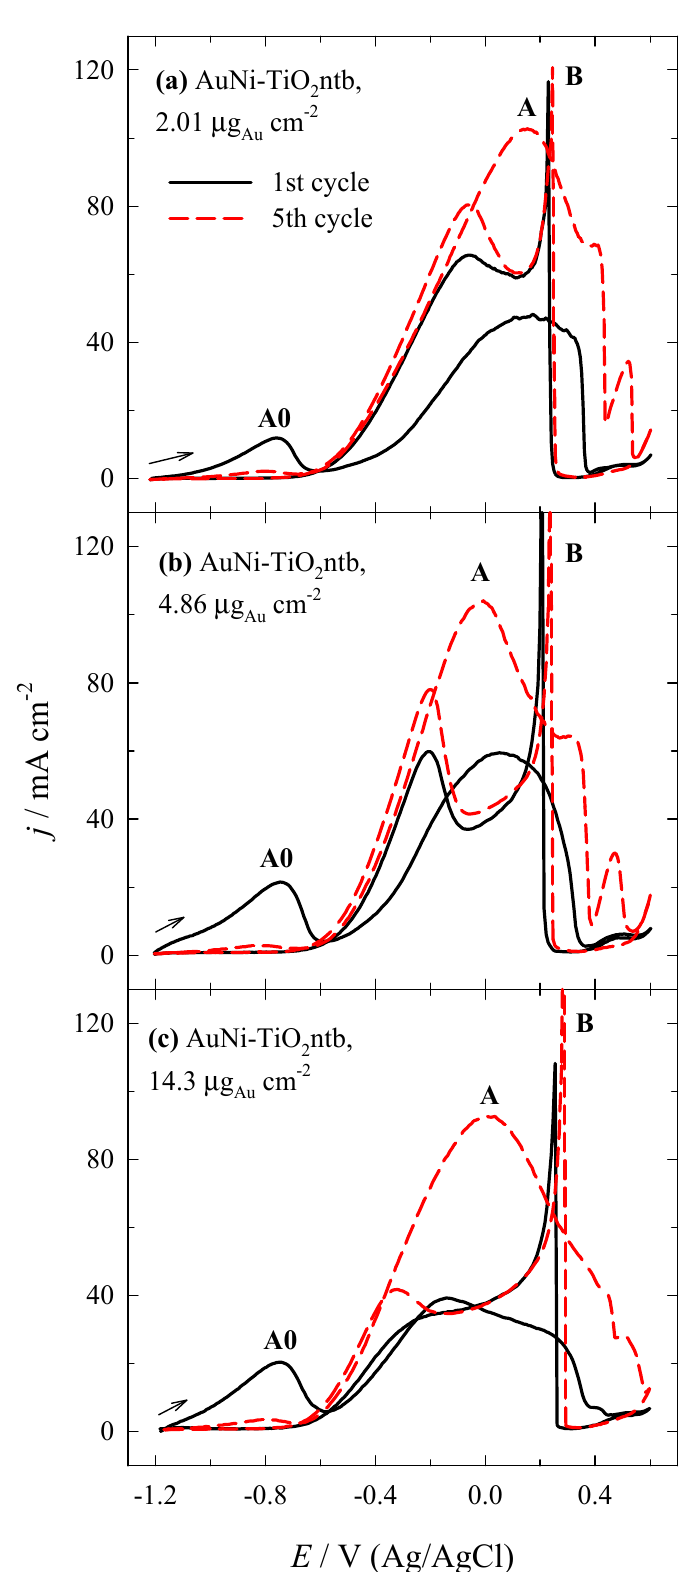
Figure 6. CVs were recorded on the different AuNi-TiO 2 ntb catalysts in a 0.05 M NaBH 4 + 1 M NaOH solution at 25 ◦ C at 10 mV · s − 1 . AuNi-TiO 2 ntbs were fabricated by the dipping of TiO 2 ntb in the Ni plating solution operated at 85 ◦ C for 20 s, followed by their dipping in the Au plating solution for time (s): ( a ) 10, ( b ) 20, and ( c ) 60.